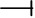
Schematic representation of major mechanisms of active forgetting in drosophila and rodents. DA, dopamine; DAMB, dopamine receptor in mushroom body (MB) neuron; D1/5, dopamine receptor subtype in mammals; DG, dentate gyrus; HP, hippocampus; PLC, phospholipase C.  represents inhibition; → represents facilitation; arrows at the right part of neurons represent behavioral outcome.